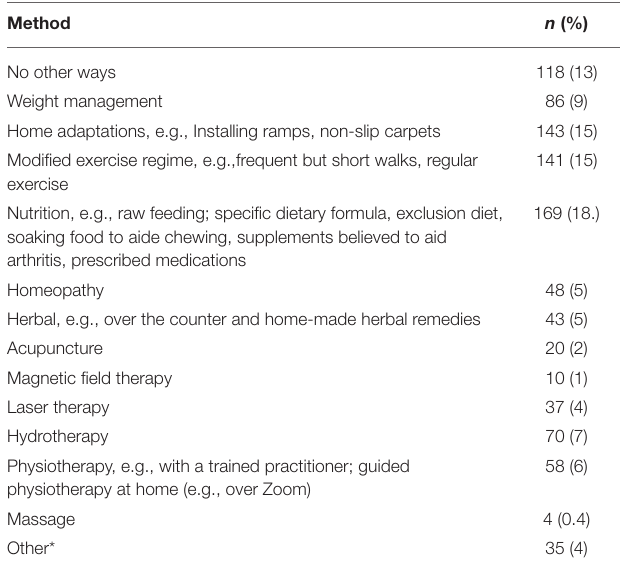
TABLE 4 | Numbers (%) of respondents who potentially needed, considered, sought, accessed and did not manage to access veterinary care for acute,